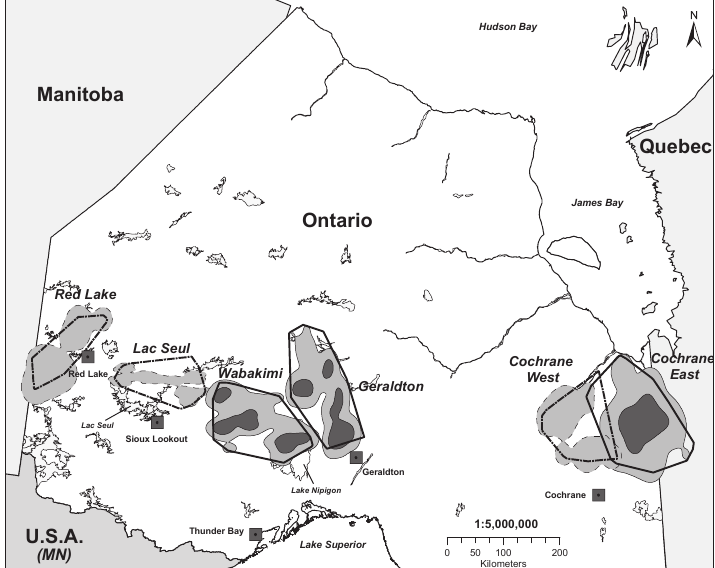
Fig. 5. Demographic unit boundaries and core areas of forest-dwelling woodland caribou ( Rangifer tarandus caribou ) at the southern limit of the ecotype’s continuous distribution in Ontario. Angular polygons outlined in black represent 100% Minimum Convex Polygons generated using all the subsampled locations of the caribou assigned to each cluster. Light gray polygons represent boundaries defined using the 95% isopleth from kernel density estimates of the utilization distributions for caribou assigned to each cluster. Polygons with dashed outlines were generated using loca- tion data from a small sample of individuals. Isopleths generated using data from relatively large, broadly distributed samples of individuals have solid outlines (i.e., Wabakimi, Geraldton and Cochrane East clusters), while isopleths generated using data from a small samples of individuals have dashed outlines (i.e., Red Lake, Lac Seul, Cochrane West). Dark gray polygons represent core areas defined using the 50% isopleth from cluster- specific kernel density estimates of the utilization distribution. These core areas were only generated for clusters with large, well-distributed samples of individuals (i.e., Wabakimi, Geraldton and Cochrane